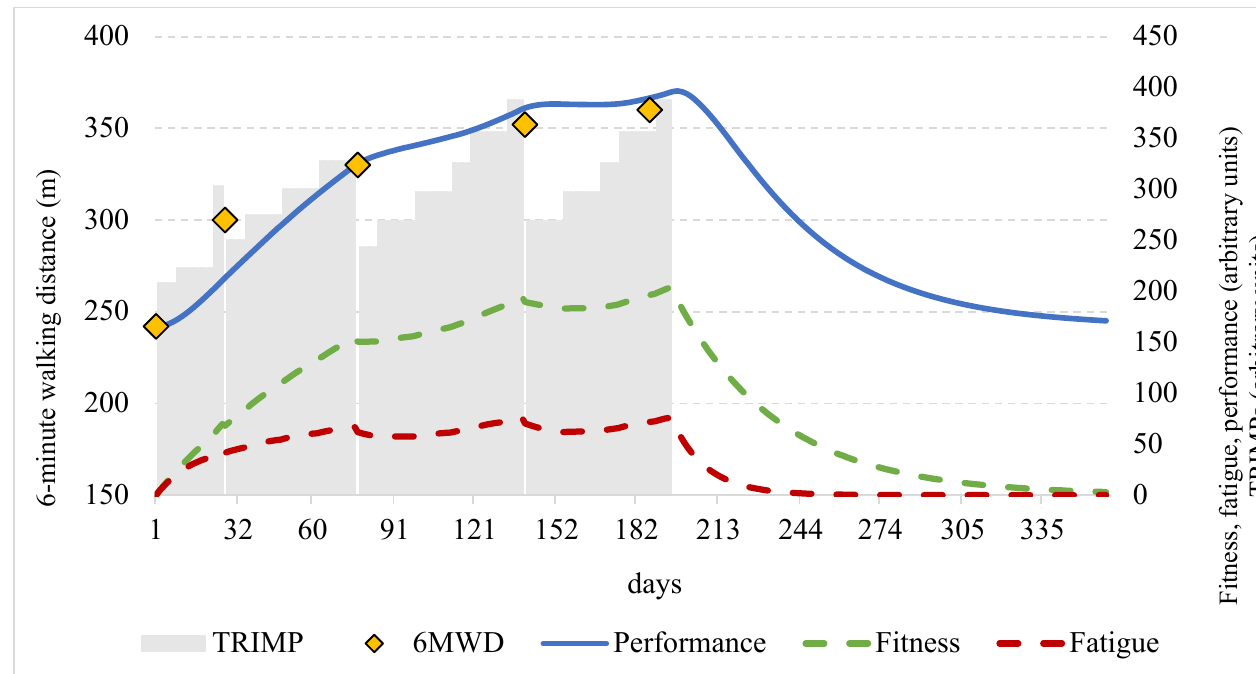
Figure 1. Description of the impulse–response model of a sample subject included in the study considering the 6MWD. Orange diamonds represent measured performance; blue line describes the predicted performance by IR model by subtracting positive training effects (fitness: green dashed line) to negative training effects (fatigue: red dashed line). Daily training impulses (TRIMPs) are also reported as grey columns. All variables represented as functions of time (days) in the horizontal axis.